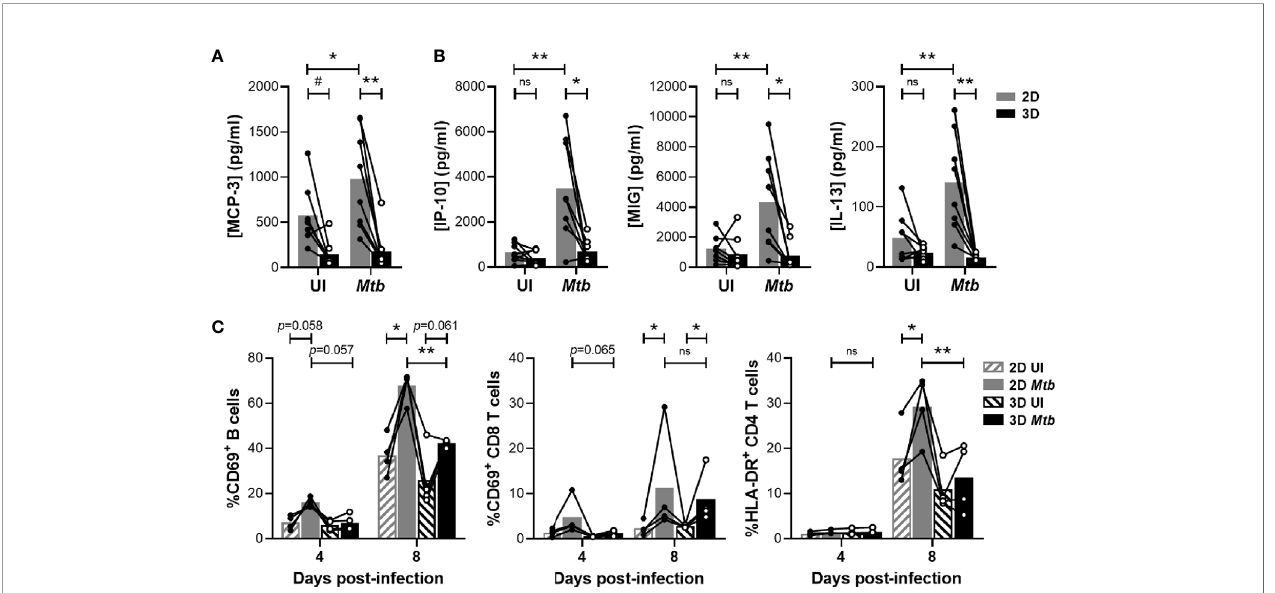
FIGURE 2 | Embedding within an ECM hampers chemokine secretion and lymphocyte activation. (A, B) Concentration of MCP-3 on day 1 (A) and IP-10, MIG and IL-13 on day 4 (B) quanti fi ed by multiplex bead-based immunoassay. UI, uninfected. (C) Proportion of activated B cells and CD4 or CD8 T cells determined by fl ow cytometry. Circles represent the value for each individual donor, lines connect results from the same donor, and bars indicate mean values of eight (A, B) or four (C) donors. Statistical analysis was performed using two-way repeated measures ANOVA and Sidak ’ s multiple comparisons test. ns, non-signi fi cant; * p < 0.05; ** p < 0.01; #, no longer signi fi cant upon correction for multiple cytokine